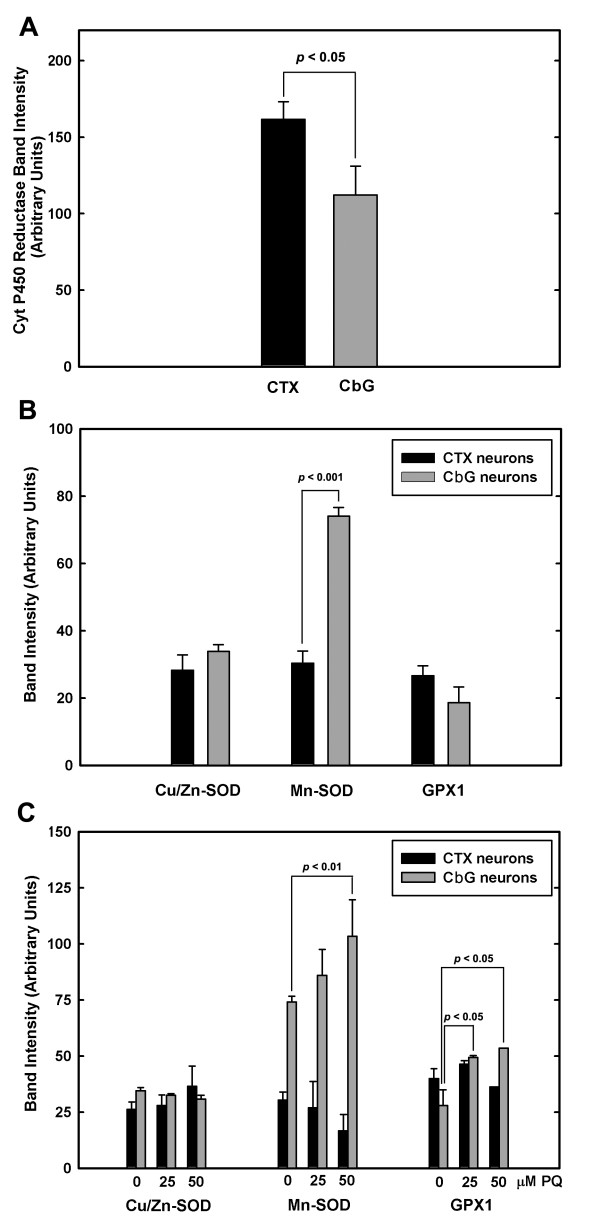
Protein levels of NADPH-cytochrome P450 reductase and for cellular oxidoreductases in CTX and CbG neurons. (A) Protein levels of NADPH-cytochrome P450 reductase in neurons. Immune labeling with anti-cytochrome P450 reductase antibodies was performed on proteins extracted from neurons cultured under conditions of 20% O2 tension. Results of densitometric measurements of the immuno-reactive band in each immunoblot are shown as the mean (± SEM) of 5 experiments. Statistically significant differences (t-test) are shown for the indicated comparisons. (B) Protein levels of SOD1, SOD2, and GPX1 in neurons. Immune labeling with anti-SOD1, anti-SOD2, and anti-GPX1 antibodies was performed on proteins extracted from neurons cultured as described in A. Results of densitometric measurements of the immuno-reactive bands in each immunoblot are shown as the mean (± SEM) of 3 experiments. Statistically significant differences (t-test) are shown for the indicated comparisons. (C) Effect of paraquat-induced OS on the protein levels of SOD1, SOD2, and GPX1 in neurons. Primary neurons in culture were exposed to the indicated concentrations of paraquat for 24 h at 37°C. Immune labeling with antibodies was performed as described in B. Results of densitometric measurements of the immuno-reactive bands in each immunoblot are shown as the mean (± SEM) of 3–5 experiments. Statistically significant differences (t-test) are shown for the indicated comparisons.